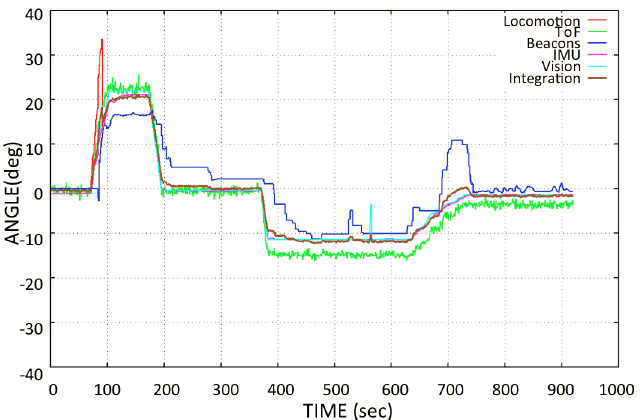
Figure 18. Transition phase test: Behavior of the orientation estimation during the transition phase when the pads turn off sequentially, shifting from one window panel to